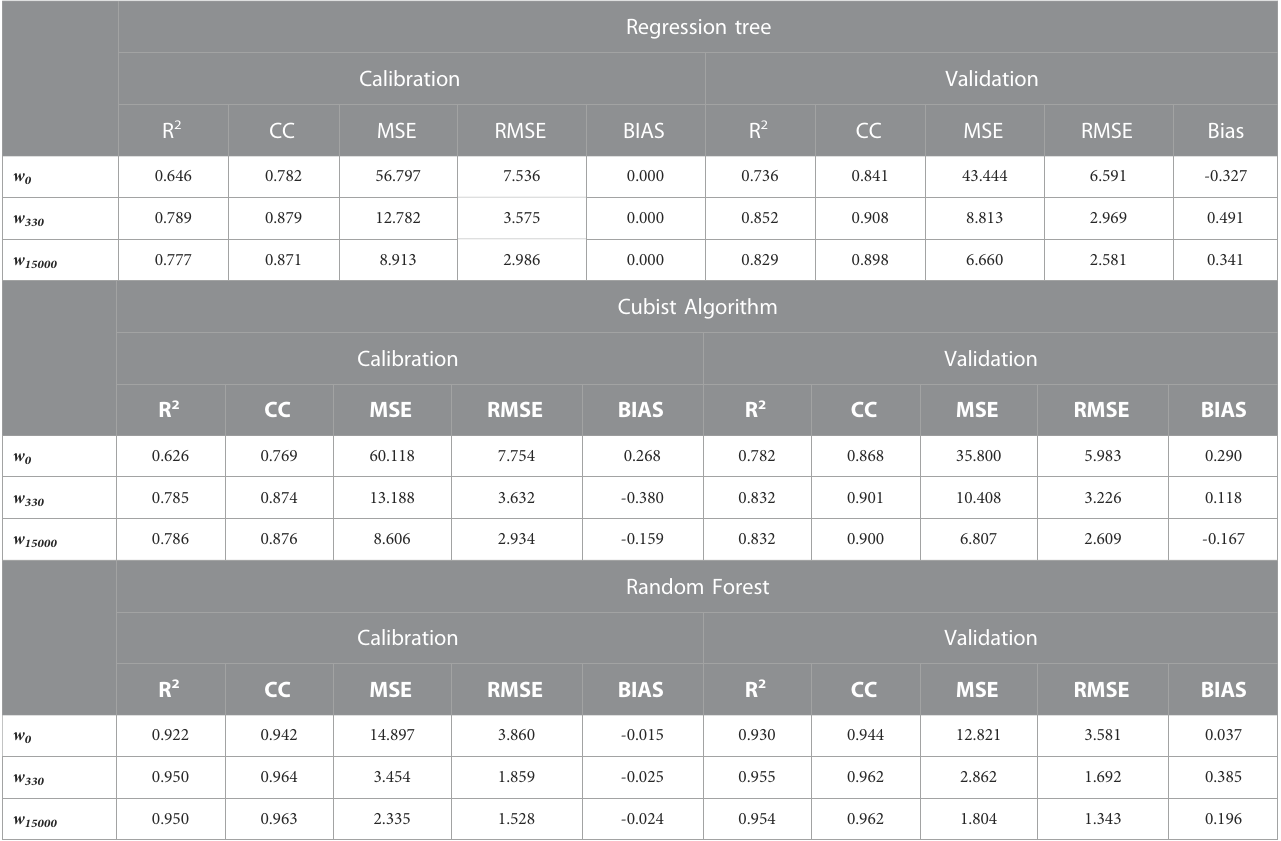
TABLE 9 Evaluation of new pedotransfer functions using regression tree, Cubist algorithm, and random forest in four regions in Morocco, assessed by the following criterion (coef fi cient of determination (R 2 ), concordance correlation coef fi cient (CC), root-mean-square error (RMSE), BIAS, mean absolute error (MAE)).